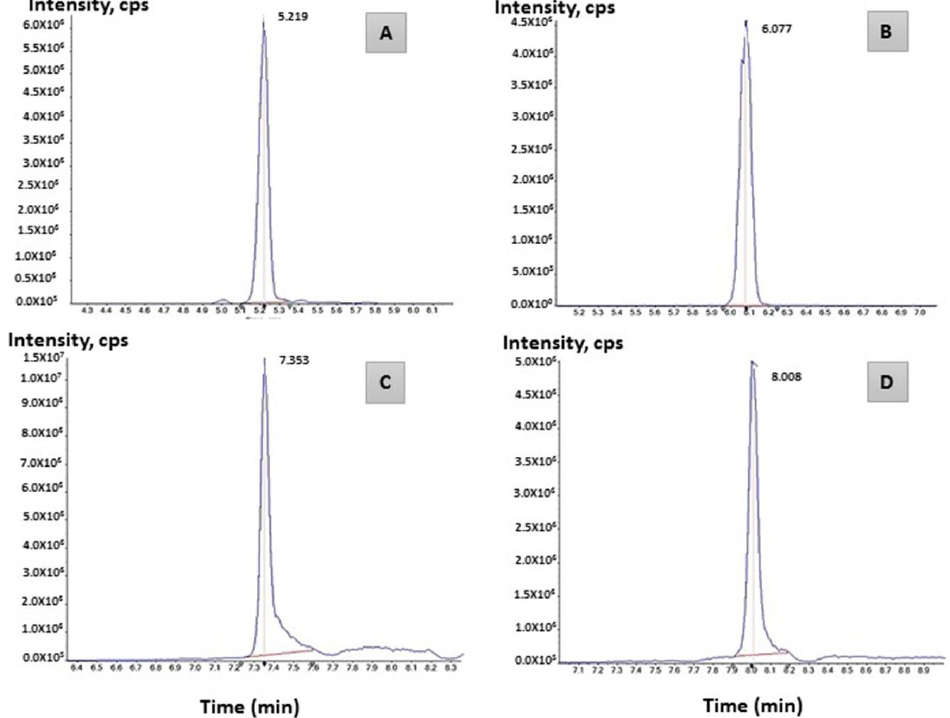
Figure 6. LC-MS spectra of Polyhydroxybutyrate standard diluted in Chloroform. Retention times (in minutes): ( A ) acetyl-CoA [RT: 5.219], ( B ) PhaB [RT: 6.077], ( C ) PhaC [RT: 7.353], ( D ) PHB [RT: 8.008].